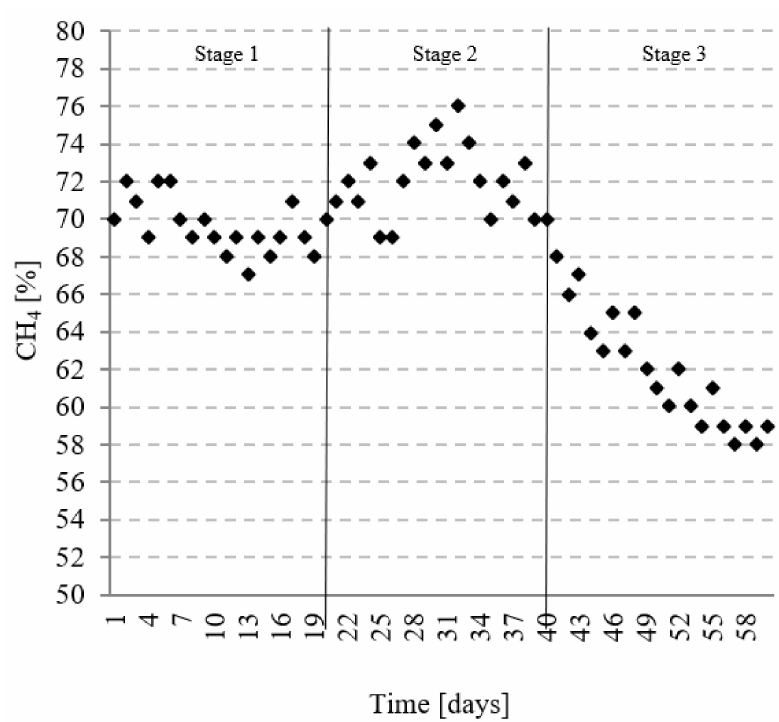
Figure 6. Methane content in the